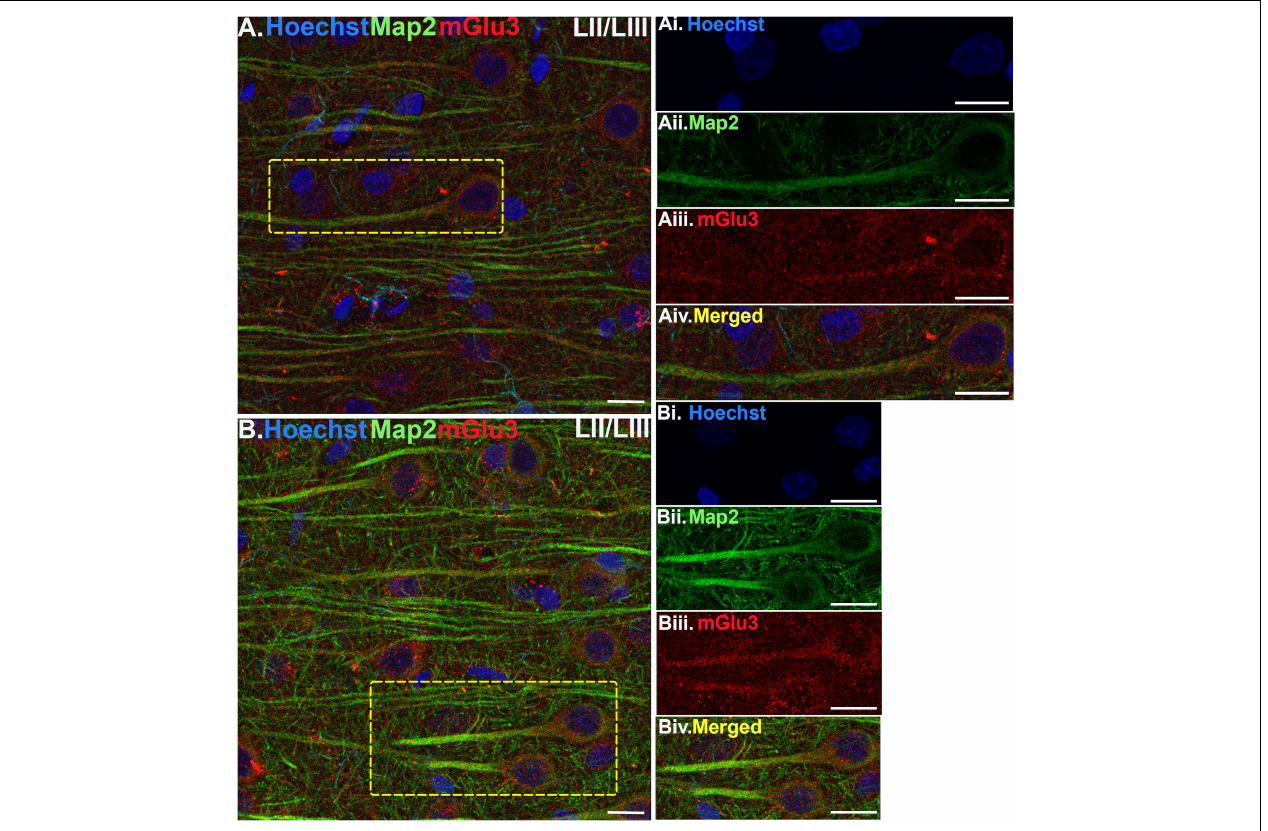
FIGURE 3 | Multiple label immunofluorescence of mGlu3 labeling in neurons in layer II/III of rat PL mPFC. Tissue was labeled with antibodies recognizing mGlu3 (red), the dendritic marker Map2 (green), as well as the nuclear Hoechst stain (blue). (A,B) In layer II/III, mGlu3 expression (red) is seen diffusely across the neuropil, with labeling within the perisomatic regions of putative pyramidal neurons as well as the apical dendrites. One representative neuron is outlined by the yellow dashed box in (A) , and two representative neurons are outlined in (B) . (Ai–iv,Bi–iv) Correspond to the boxed areas in (A,B) . In both (Aii,iii,Bii,iii) mGlu3 labeling clearly outlines the apical dendrite, as demarcated by Map2 (green) and surrounds the nucleus (blue). Scale bars: 10 µ m.